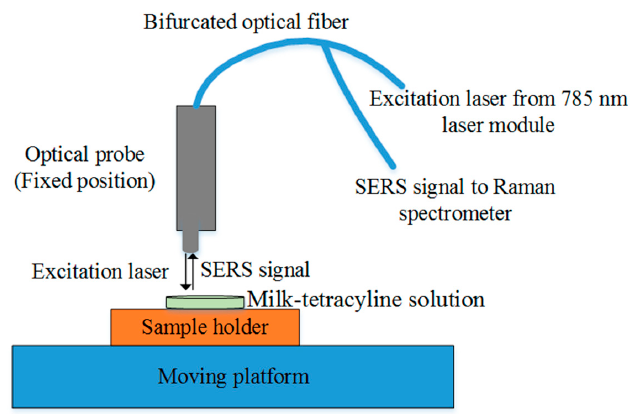
Figure 1. Schematic of the portable surface-enhanced Raman spectroscopic system.